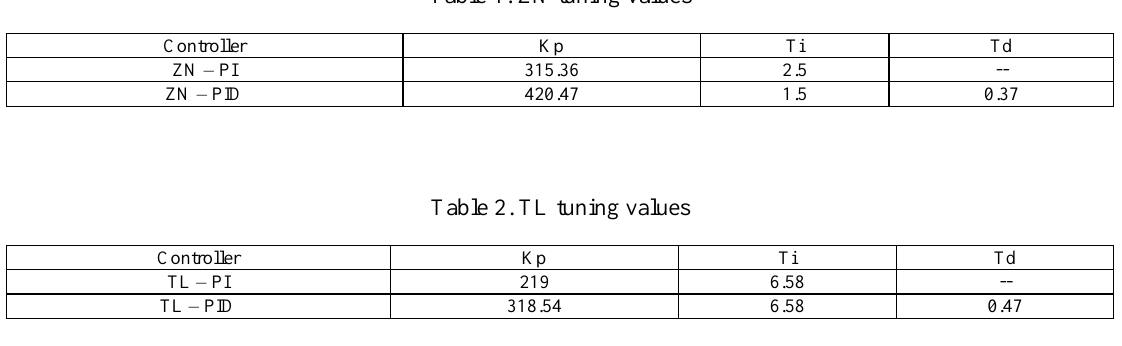
Table 1. ZN tuning values